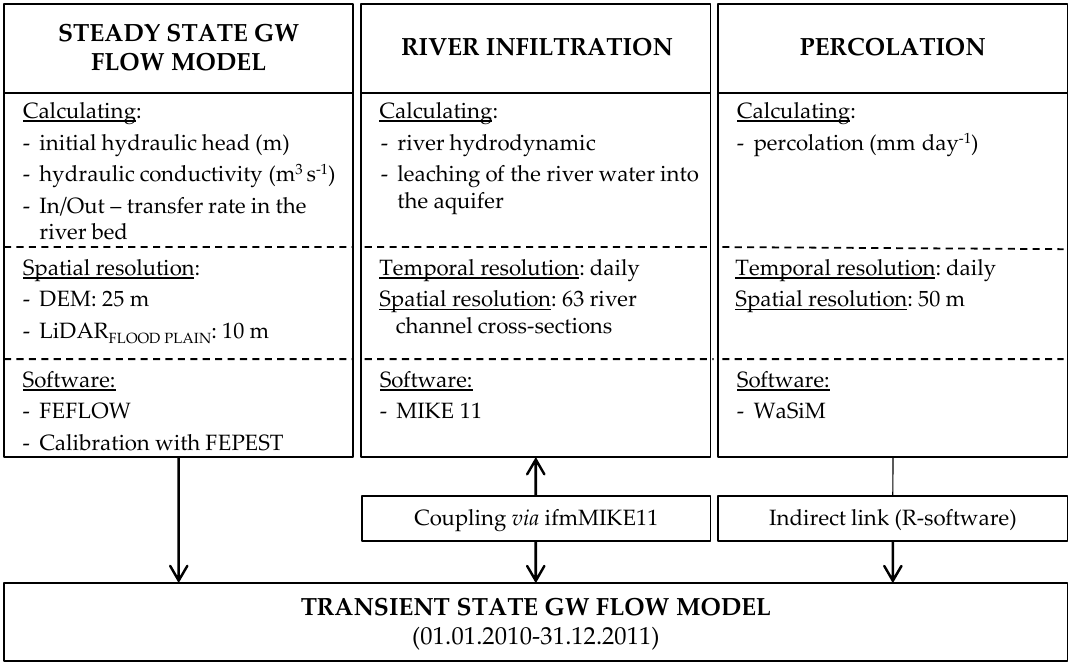
Figure 3. The hydrological modeling framework.